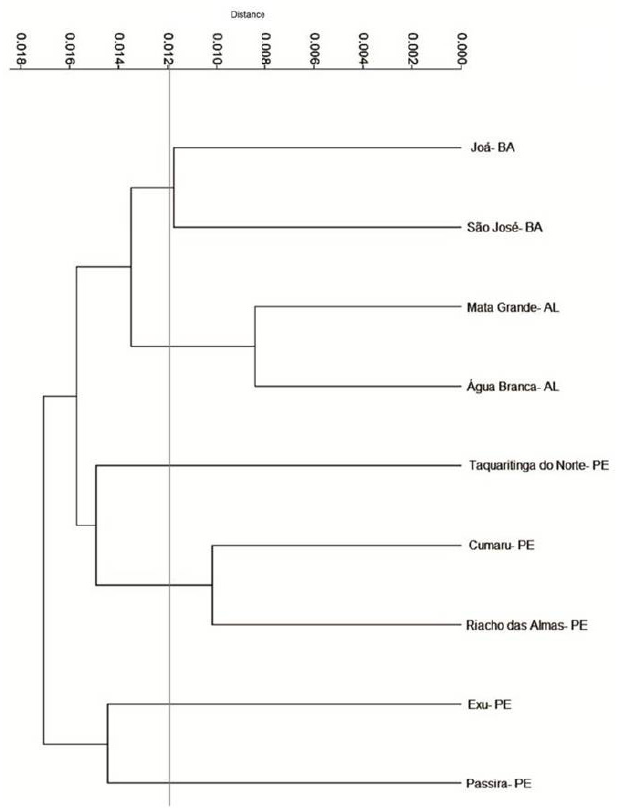
Fig 2 Dendrogram generated by UPGMA with the average morphometric distances between Melipona subnitida colonies from different localities.